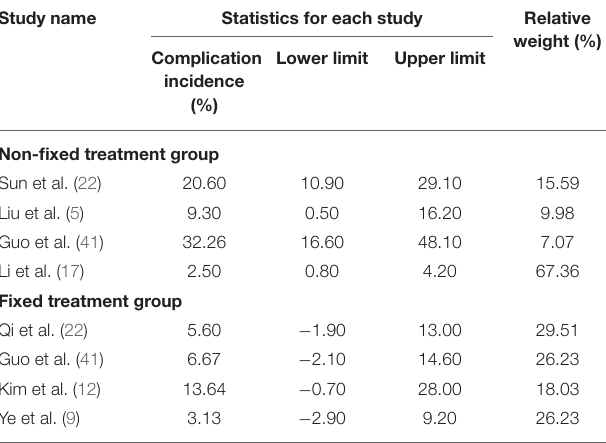
TABLE 4 | Statistics of the secondary outcome indicator of included